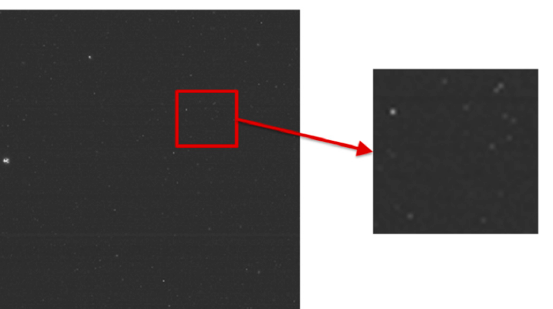
Figure 4. The random noise caused by the impact of cosmic radiation particles and temperature.